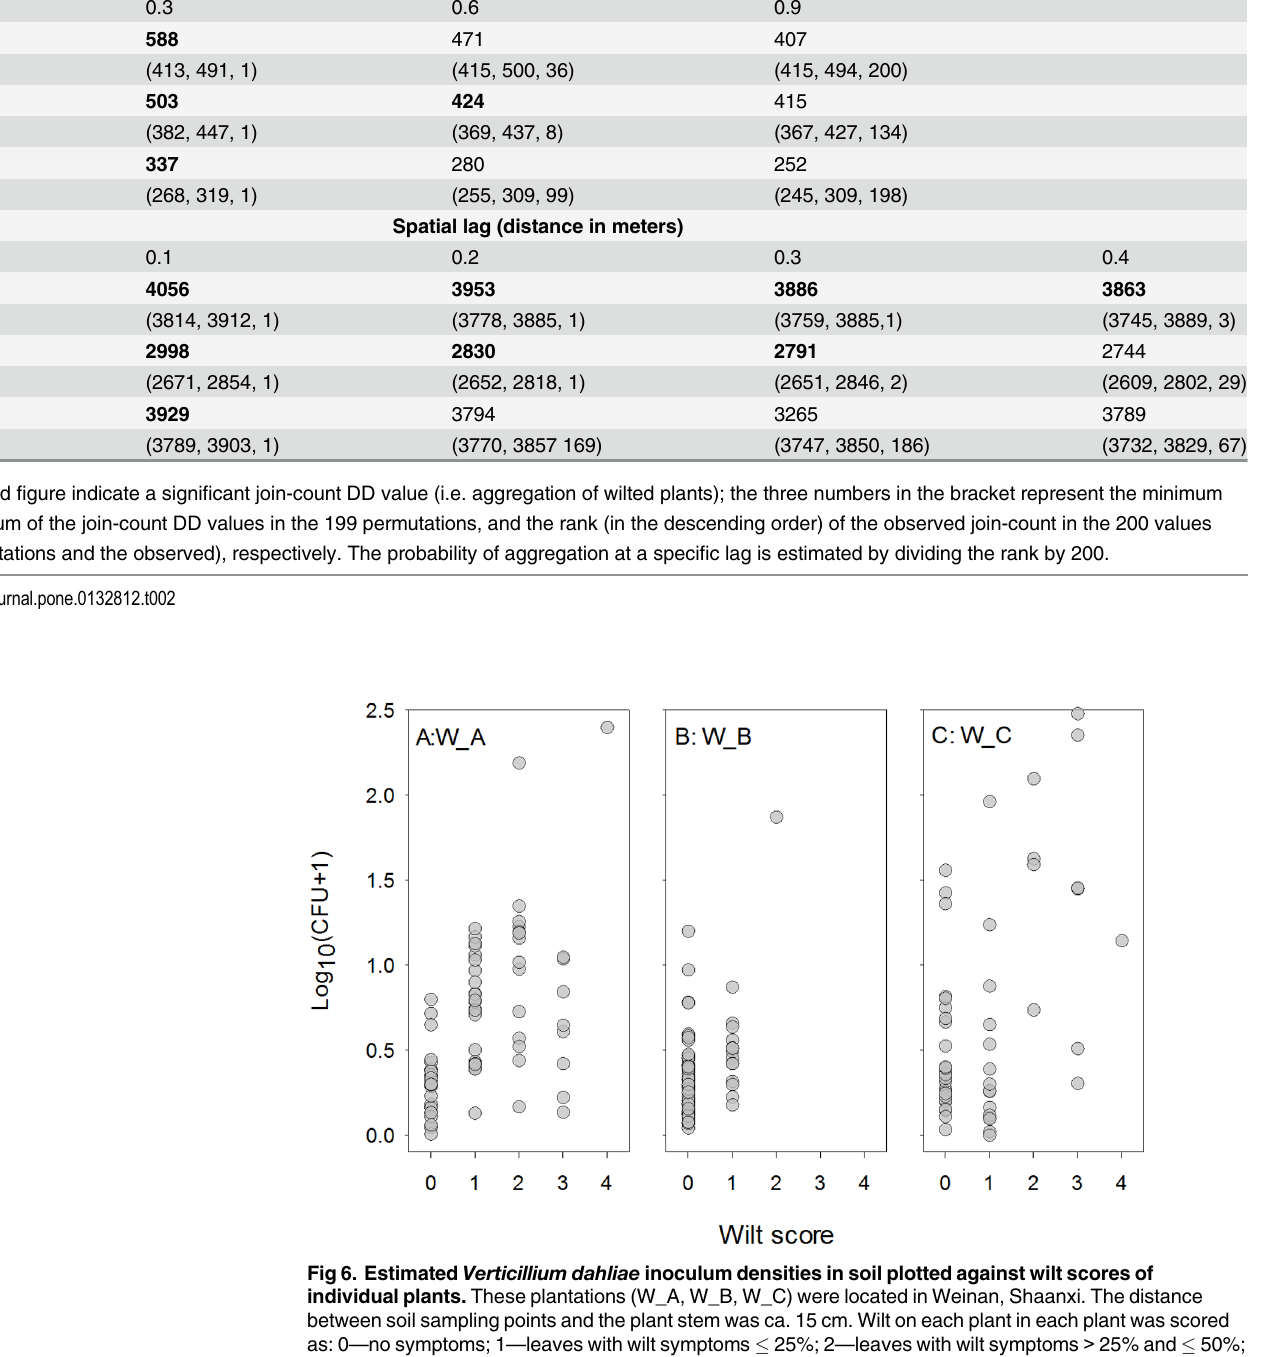
Table 2. Within-row join-count test results for aggregation of cotton plants with wilt symptoms in three commercial fields in Weinan, Shaanxi for spatial lags with significant or close-to-significant aggregation detected. Wilt was assessed in late August 2013. There was no between-row aggrega- tion for three fields in Weinan; between-row join-count analysis was not done for the three Xinjiang fields because of variable row-to-row distances. a Weinan